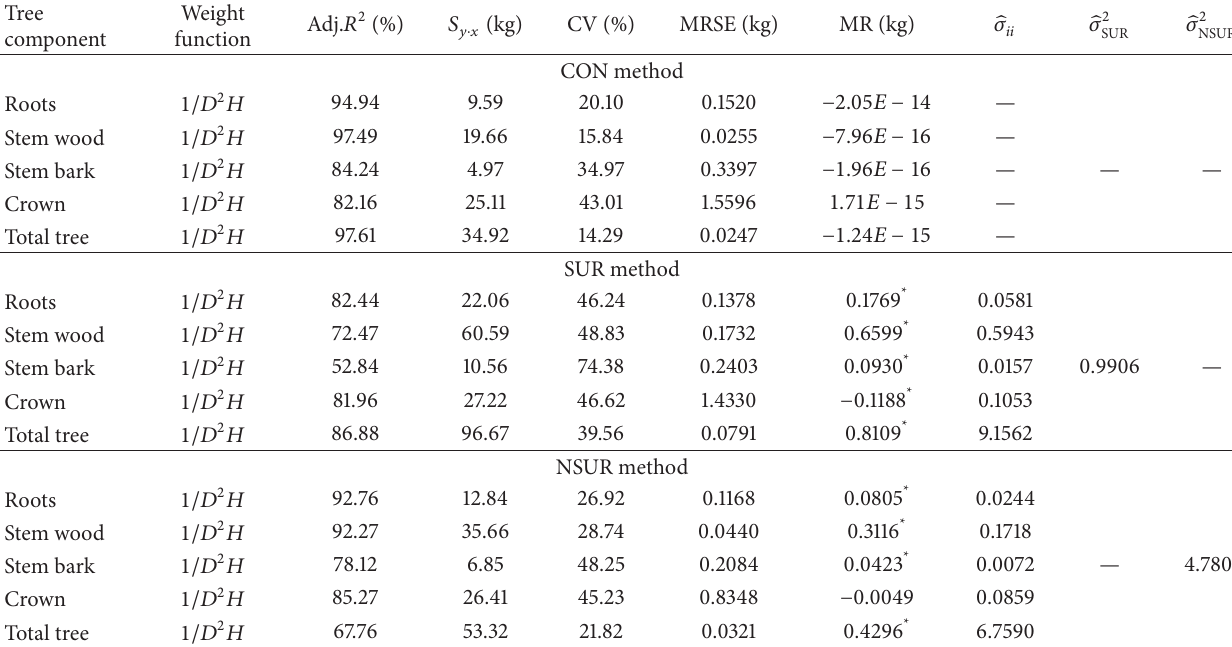
Table 7: Fit statistics for CON, SUR, and NSUR